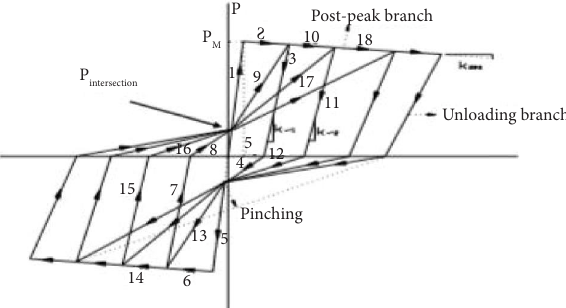
Figure 17: Loop modelling.